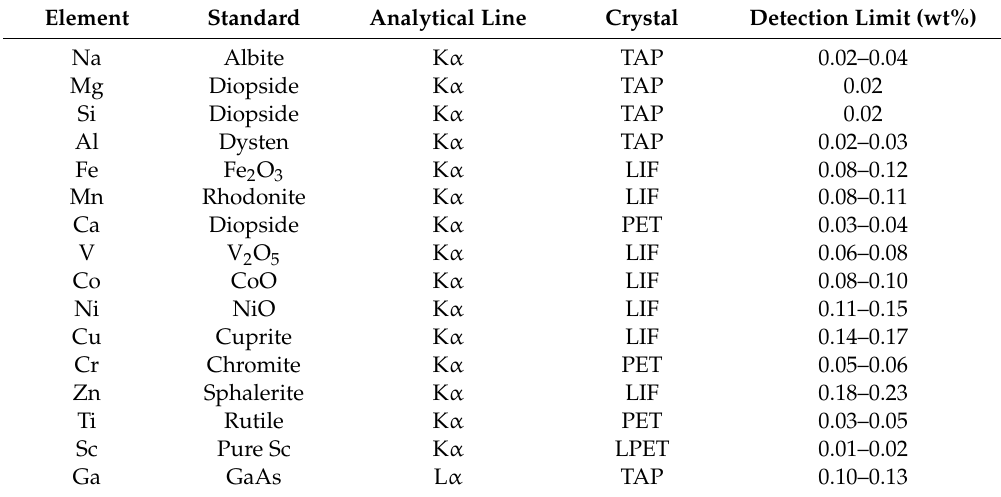
Table 1. Electron probe microanalyzer (EPMA) calibration